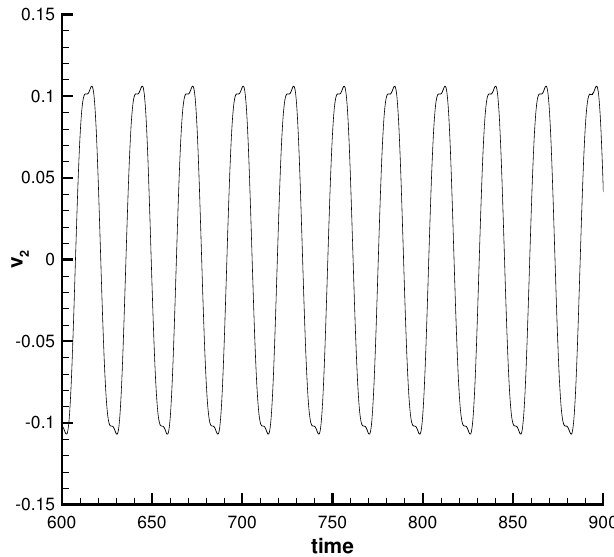
Figure 19. Time series of the velocity component v 2 ( x p , t ) at x p = ( 10,0 ) in the time interval [ 600,900 ] . The resulting Strouhal number is St = t ∈